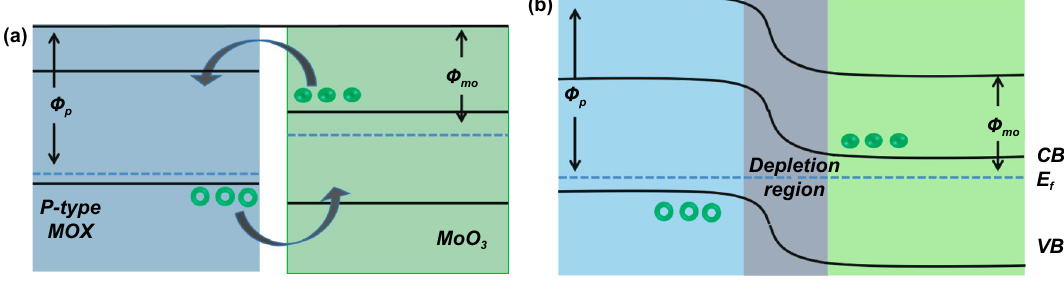
Fig. 7 Illustration of band diagram of p-type metal oxide and n-type MoO 3 a before and b after making contact. The depletion region is created at the interface as a result of electron–hole recombination during Fermi level